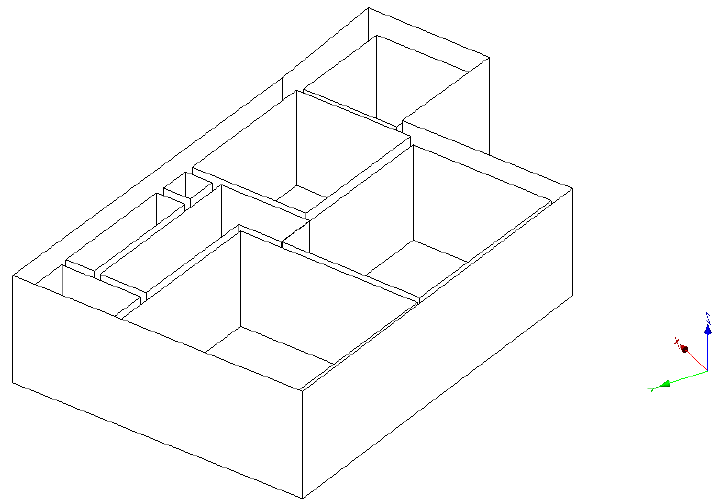
Figure 7. Plan B, extruded models viewed as CityGML.